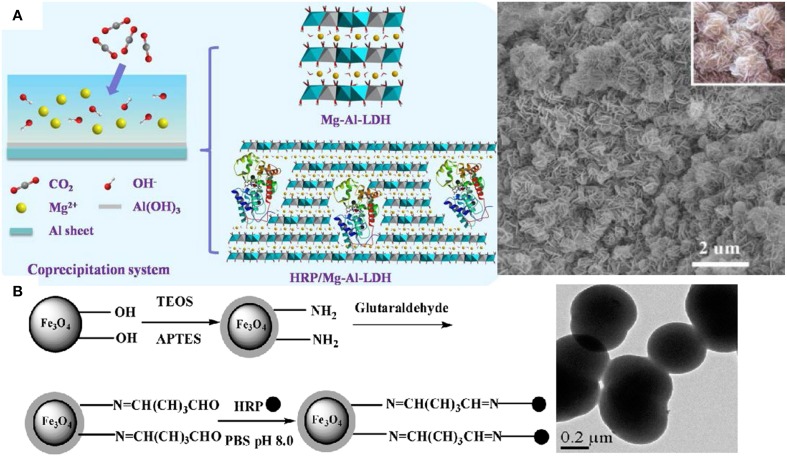
Nanostructures for immobilizing and reusing peroxidases. (A) Entrapment of HRP in inorganic matrix of flowers like nanomaterial (Wang et al., 2014). (B) Covalent attachment of HRP on NH2 –modified Fe3O4/SiO2 magnetic nanoparticles (Chang and Tang, 2014).